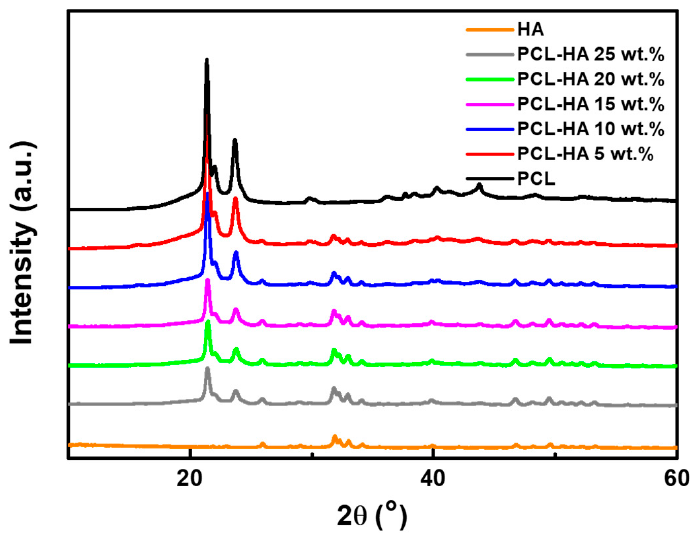
Figure 4. XRD patterns of the PCL/HA composites. Characteristic peaks corresponding to HA and PCL can both be observed in the PCL/HA composite filaments.